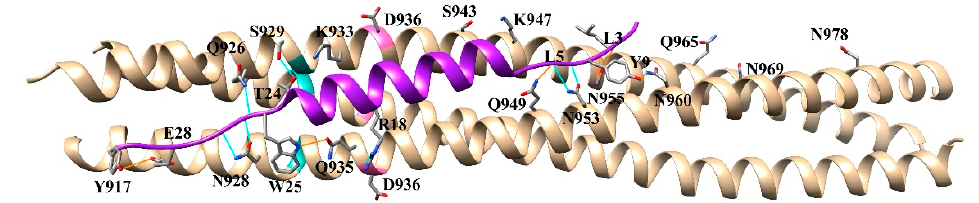
Figure 7. Hydrogen bonding interactions between the SARS-CoV-2 WT HR1 domain and peptide inhibitor 132D. Hydrogen bonds are shown with blue or orange lines. Blue hydrogen bonds fall within the precise geometric criteria of 2.5 angstroms and theta is greater than 90 degrees [56]. Orange hydrogen bonds fall within the tolerance criteria for H-bond relaxed constraints of 0.4 angstroms and 20.0 degrees.